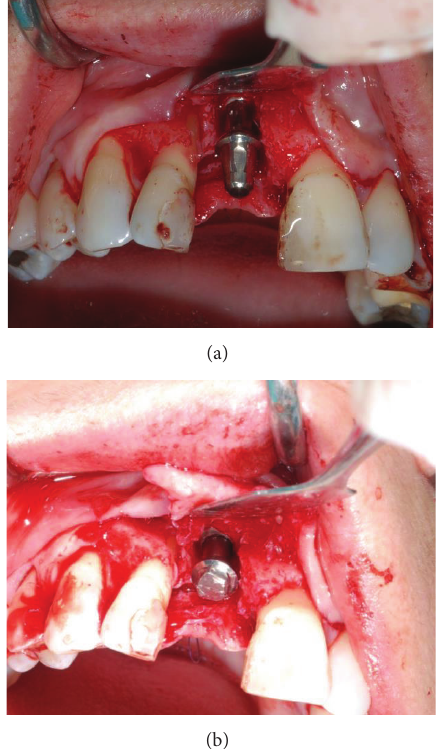
Figure 12: A stealth abutment was tested (a) and then modified on its top (b) to primarily close the wound maintaining a proper bone and mucosal